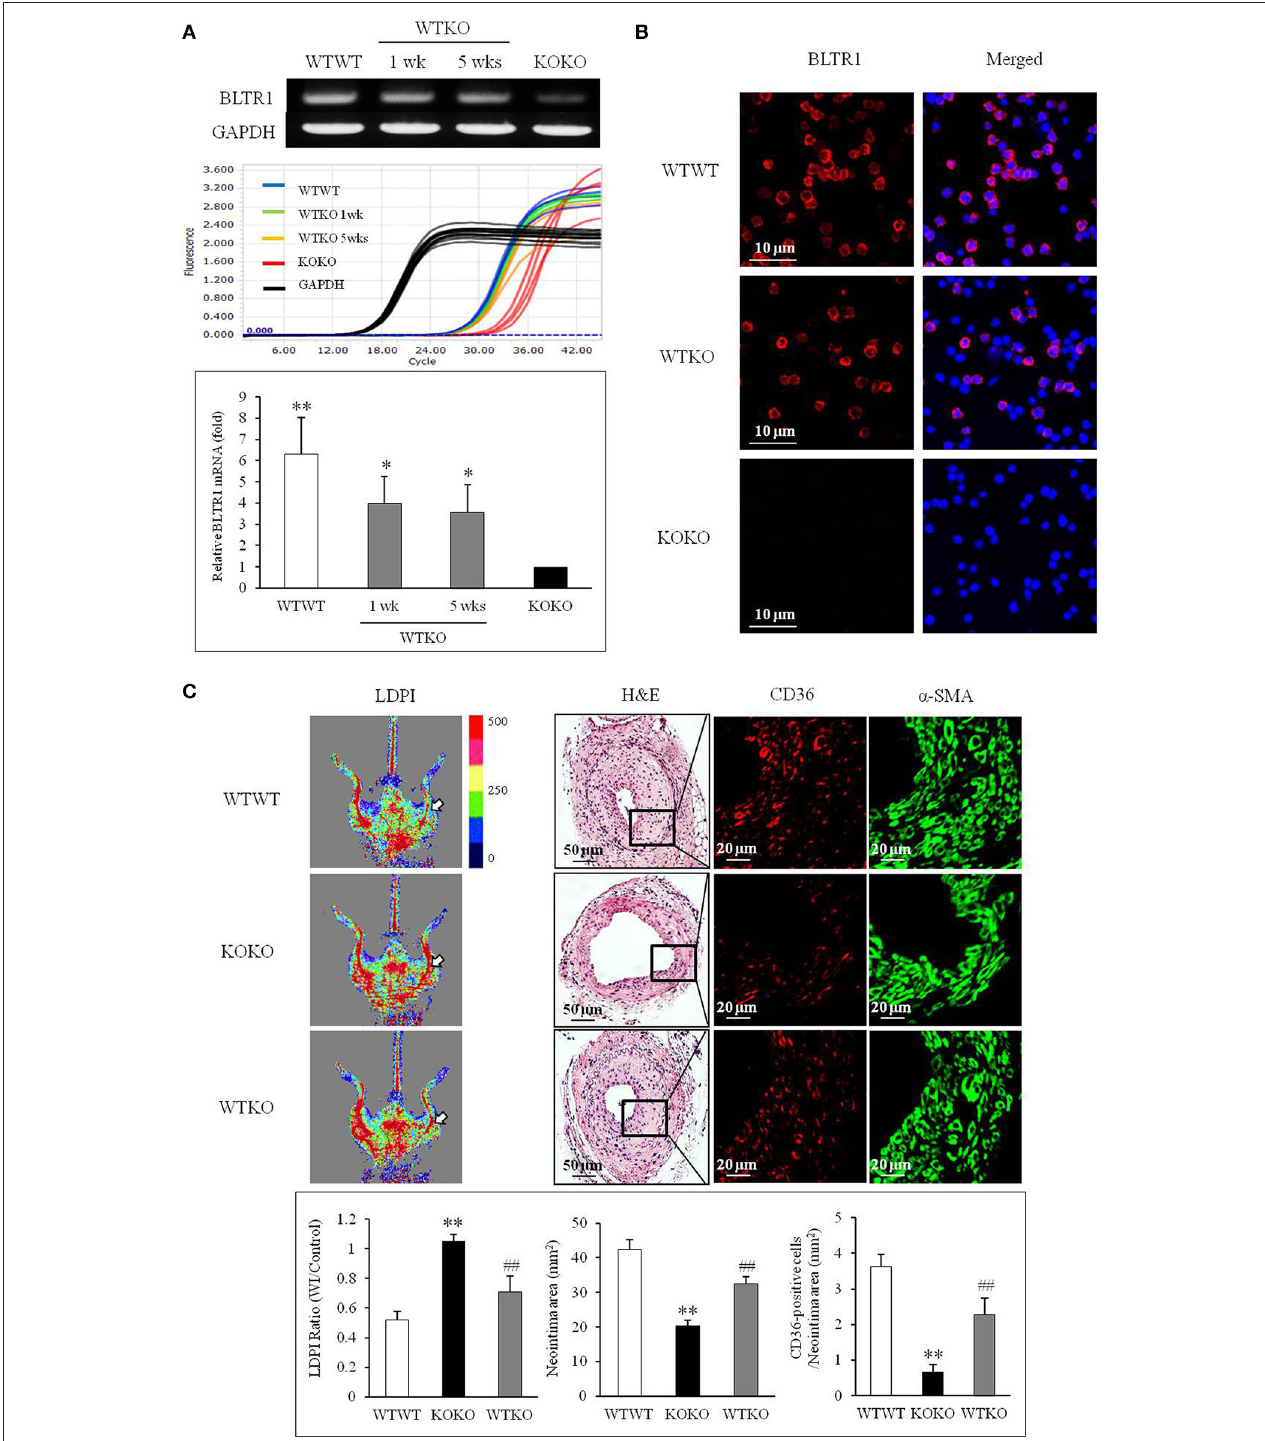
FIGURE 6 | Identification of a pivotal role for BLTR1 in monocytes on vascular inflammation and neointima formation in the wire-injured femoral artery. (A) Expressions of BLTR1 mRNA in PBMCs isolated from three groups of mice transplanted with BMDMs (WTWT, WT cells into WT mice; KOKO, BLTR1-deficient cells into BLTR1-deficient mice; and WTKO, WT cells into BLTR1-deficient mice) were determined by Real Time PCR. PCR signals were quantified, and data were presented as the means ± SEMs of 4–5 independent experiments. * P < 0.05; ** P < 0.01 vs. KOKO mice. (B) Expressions of BLTR1 protein in PBMCs isolated from these three groups of mice at 5 wks post-transplantation were determined by immunocytochemistry. Photographs are representative of 3–4 independent experiments.